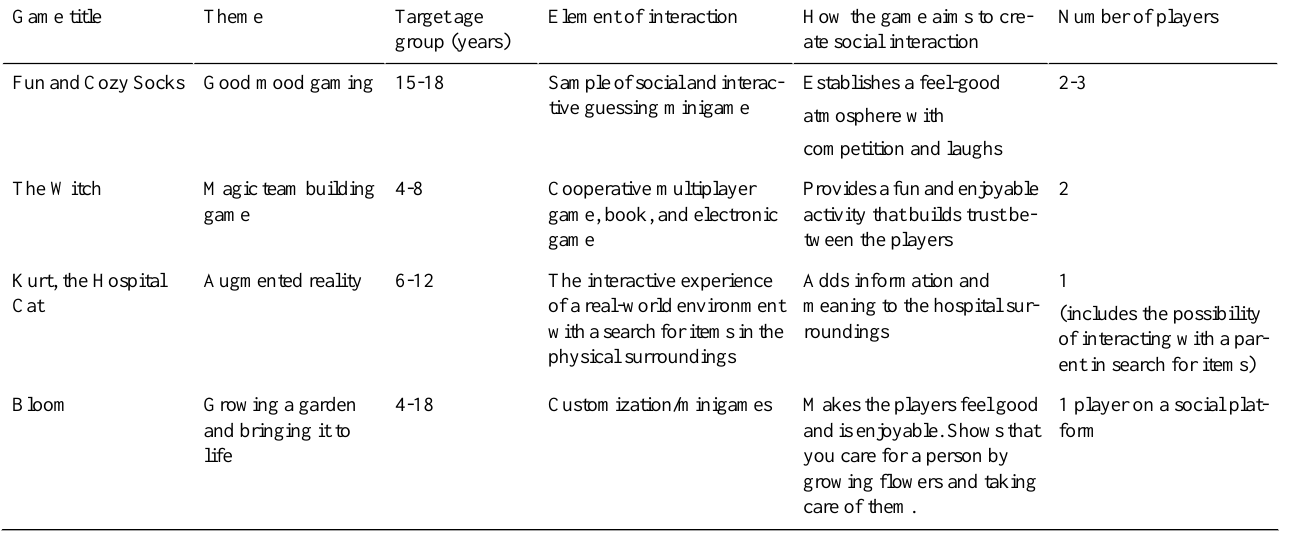
Table 1. Prototypes of the games.